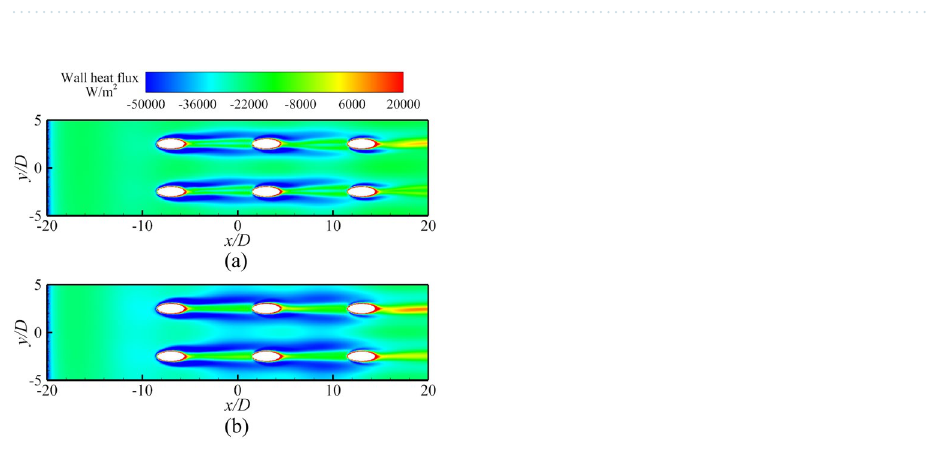
Figure 25. Distribution of dimensionless temperature θ at slice y / D = –2.5. ( a ) Re = 2900; ( b ) Re = 3700.